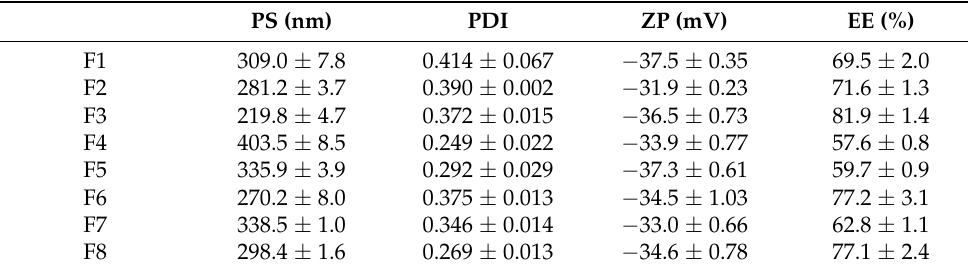
Table 3. Observed responses for the prepared TEs